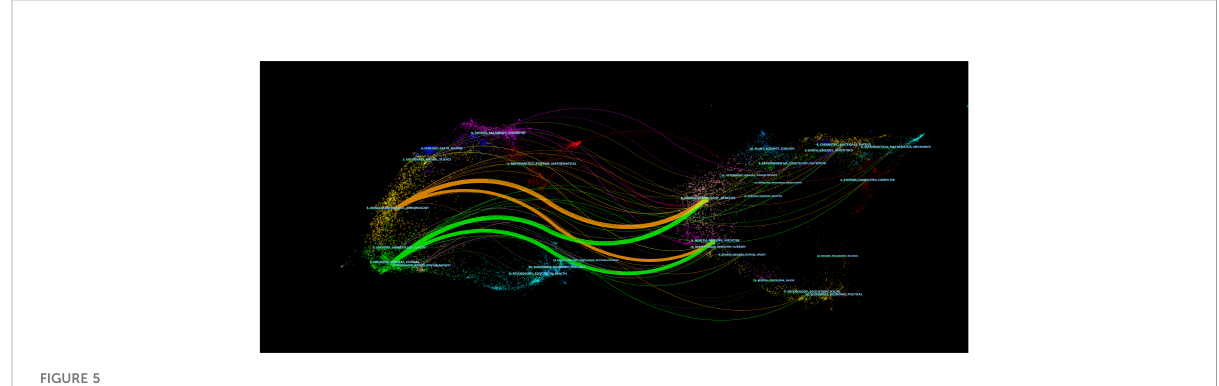
FIGURE 5 The dual-map overlay of journals.